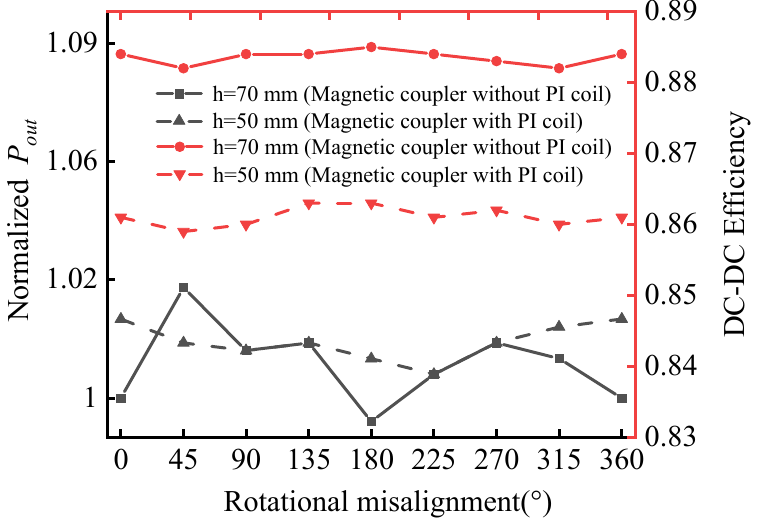
Figure 19. The output power and efficiency varying with rotational misalignments.